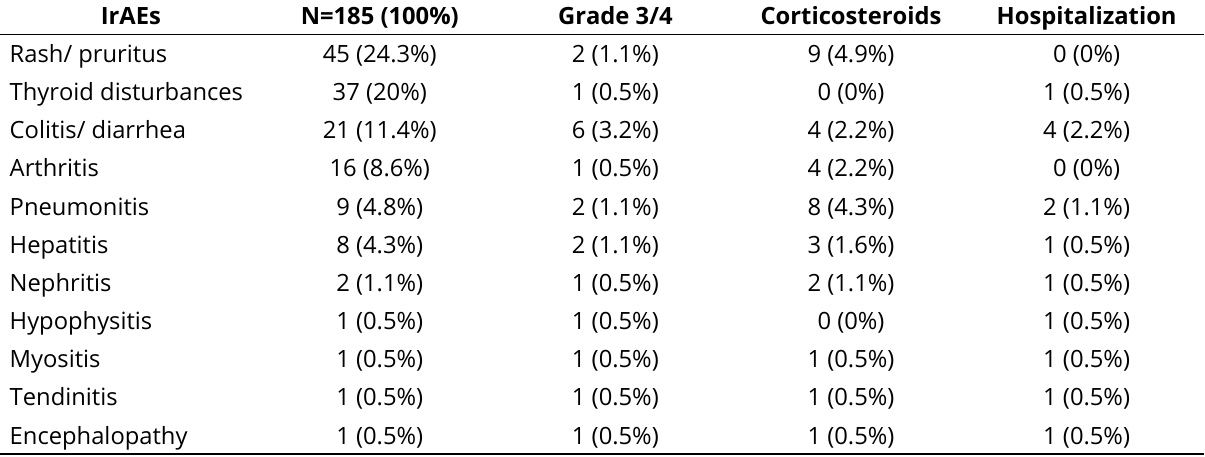
Table 2. Immune-related adverse events with at least one case grade ≥3.